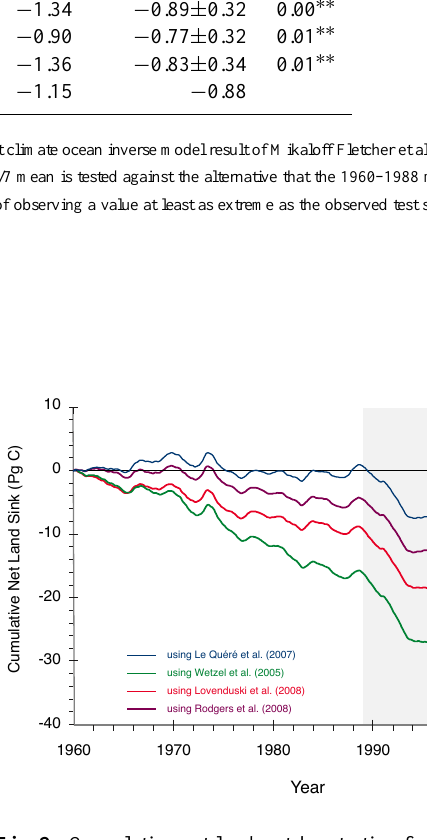
Fig. 2. Cumulative net land uptake starting from 1960 calculated from the results in Fig.